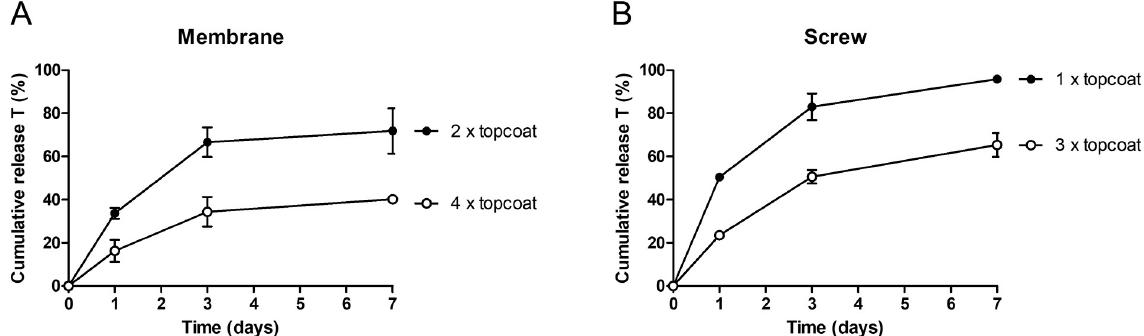
Fig 1. Effect of additional topcoat layers of PLGA 5004A on the cumulative in vitro release of testosterone (T) from coated membranes and screws. Addition of 2 and 4 topcoat layers on coated membranes (A, n = 2) and addition of 1 and 3 topcoat layers on coated screws (B, n = 2) reduced the in vitro release of testosterone and prevented burst release of testosterone at day